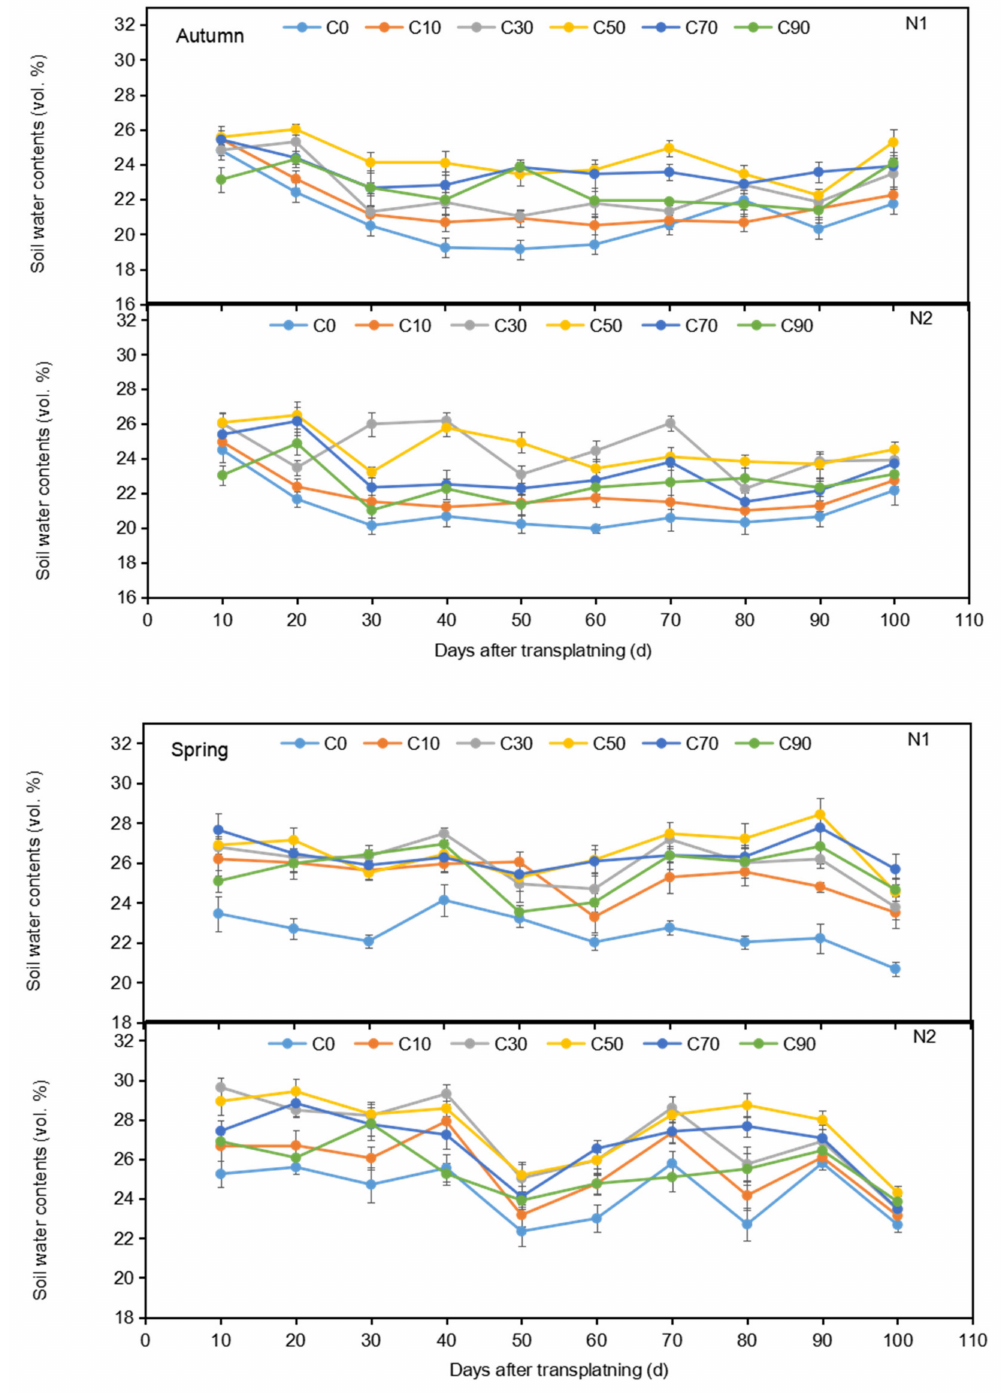
Figure 1. Daily changes of the average volumetric soil water content (%) for soil with different N fertiliser (N1 and N2) and biochar (C0, C10, C30, C50, C70, and C90) treatments. Error bars represent standard